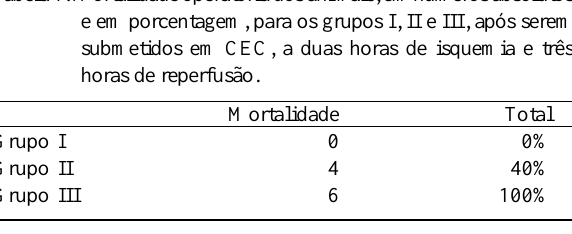
Teste Estatístico - Teste Exato de Fisher Grupo I x Grupo II - p =